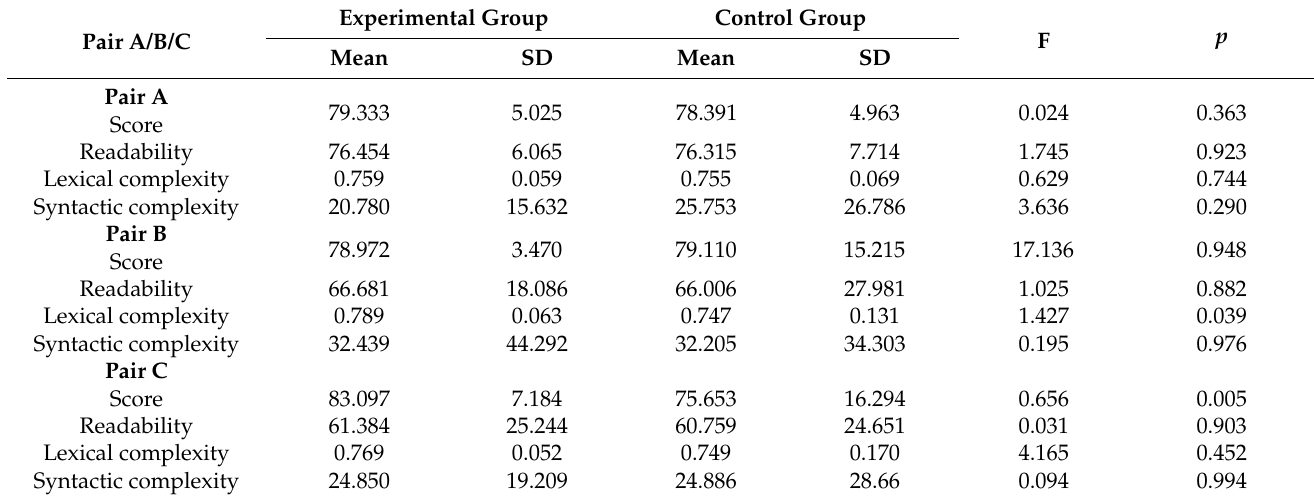
Table 4. Analysis of variance of the pretest.